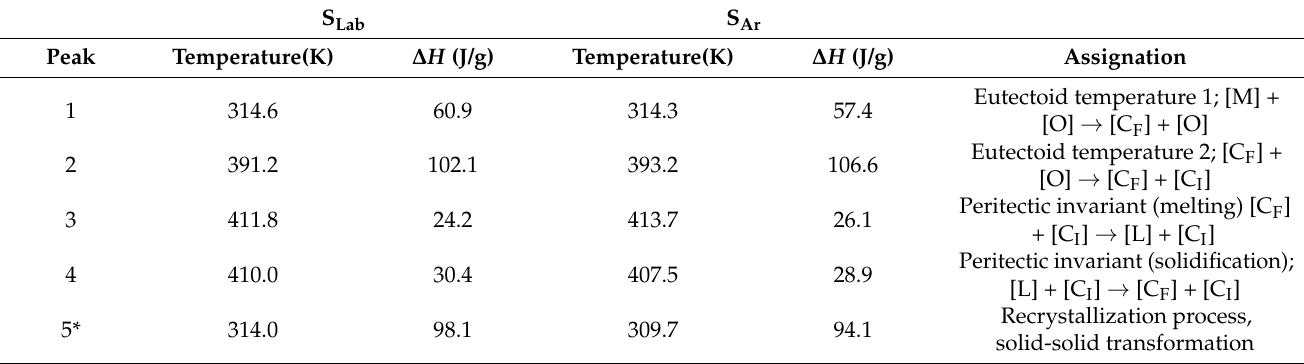
(*) 2nd cycle of thermal treatment. [M] = monoclinic; [O] = orthorhombic; [C F ] = face-centered cubic; [C I ] = body-centered cubic; [L] = liquid. The experimental values have associated error of 5%, as a conservative upper